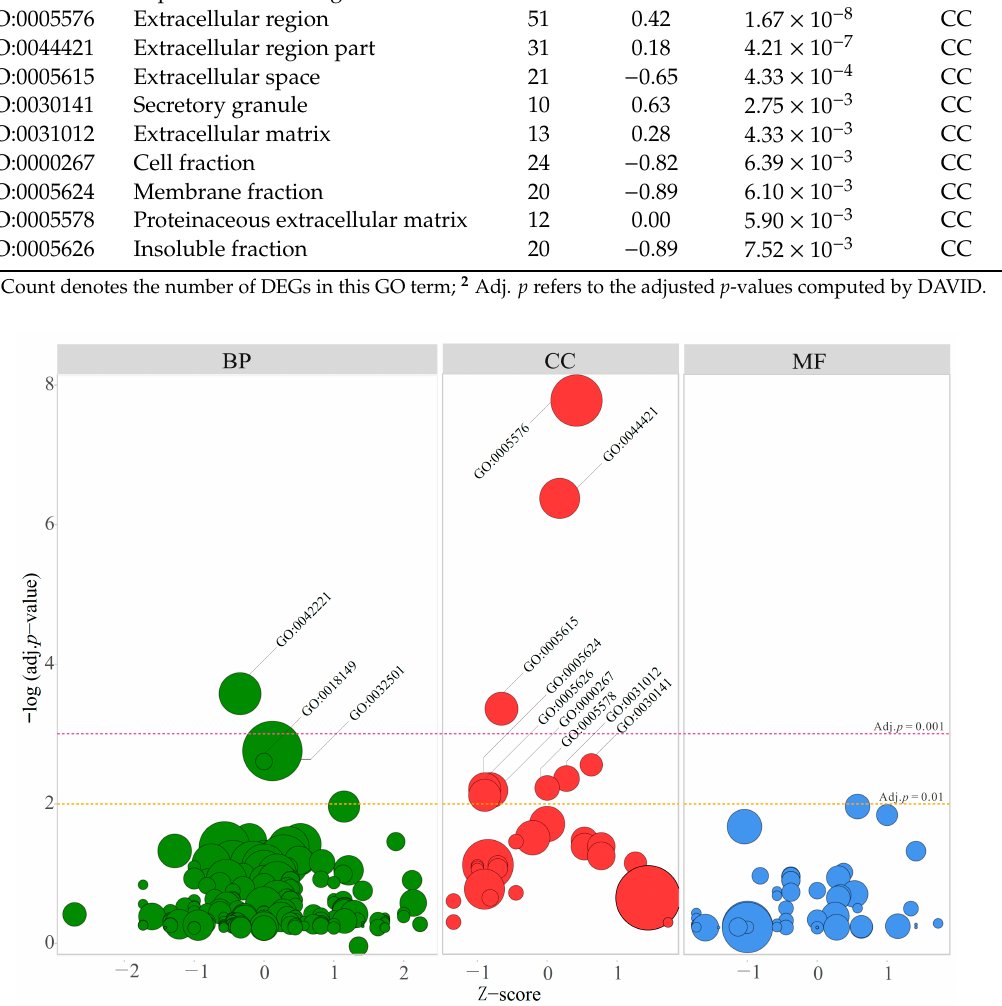
Figure 4. Bubble plot for GO term enrichment. The bubble size represents the number of DEGs in each GO term. Three levels of GO terms are the biological process (BP), cellular component (CC), and molecular function (MF). Table 4. Enriched KEGG (Kyoto Encyclopedia of Genes and Genomes) pathways for DEGs using